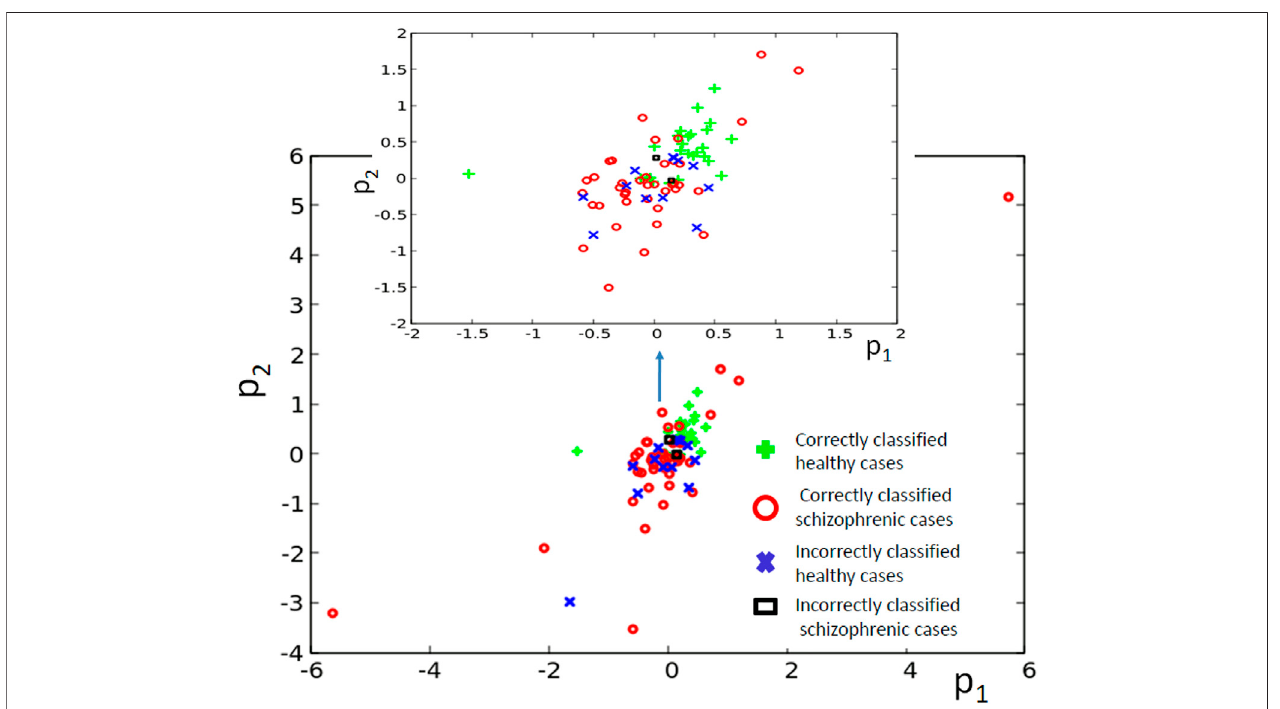
FIGURE 12 | The distribution of correctly and incorrectly classi fi ed cases for 6-oscillator network (cf. Figure 2D ) in the phase space ( p 1 , p 2 ).